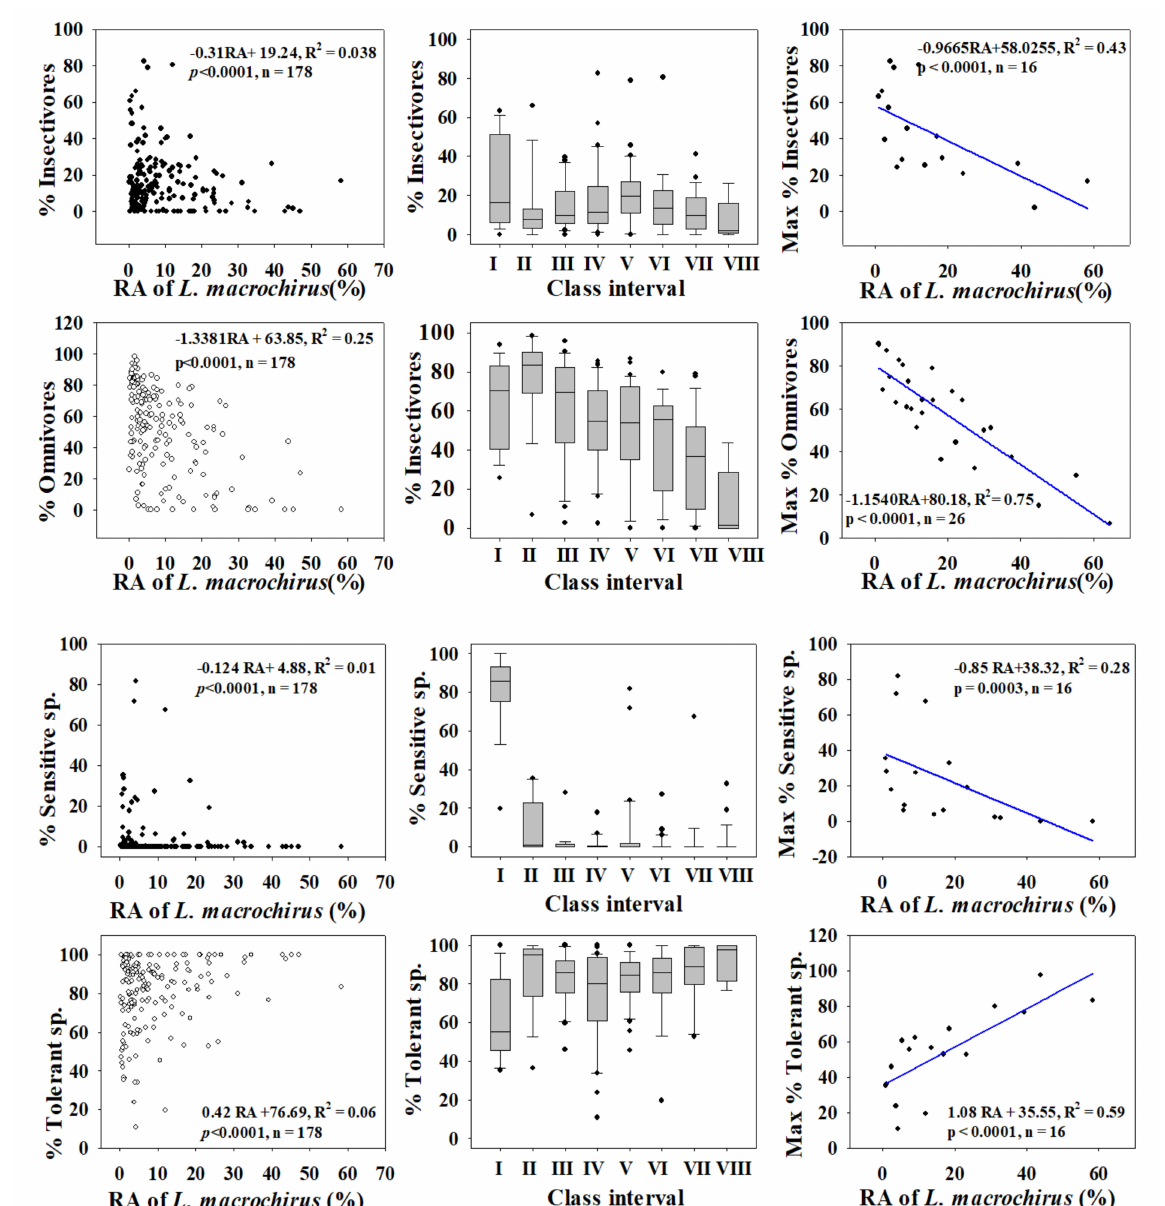
Figure 4. Dynamics of trophic and tolerance guilds in relation to the relative abundance (RA %) of Bluegill ( L. machrochirus